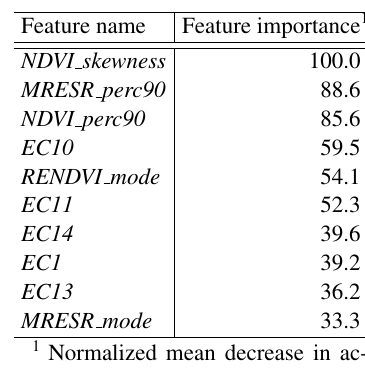
Table 5. Top 10 features using RF classifier and all data